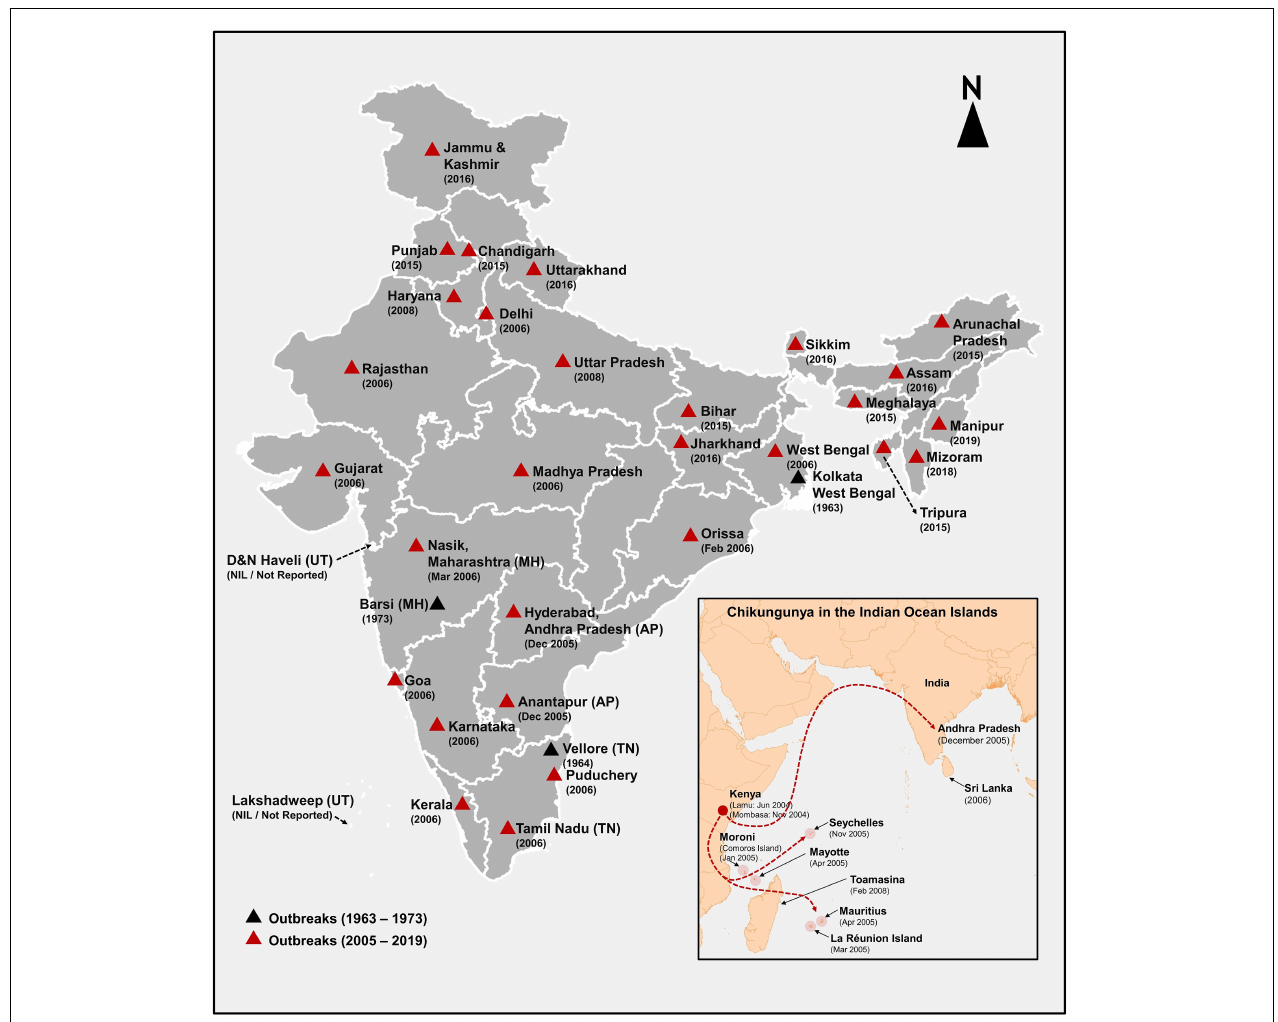
FIGURE 3 | Reported chikungunya outbreaks in India and Indian Ocean Islands (IOI) shows the year of onset of chikungunya outbreaks between 1963 and 2019 in India and the change in genotype from Asian (during the 1963–1973) to ECSA (2005–2019) is sketched in black and red triangles. The data source for generating. This figure is from NVBDCP (2014-15); National Health Profile (2019); National Center for Disease Control